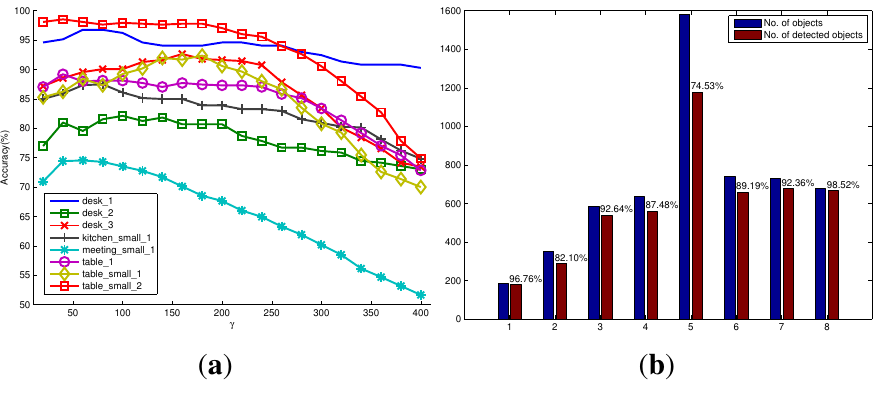
Figure 8. Quantitative evaluation on the RGB-D scene dataset with eight scenarios. ( a ) The successful detection percentages versus the parameter γ in the model of object hypothesis for eight scenarios, respectively; ( b ) the number of objects, as well as the number of detected objects in each scenario using the optimal